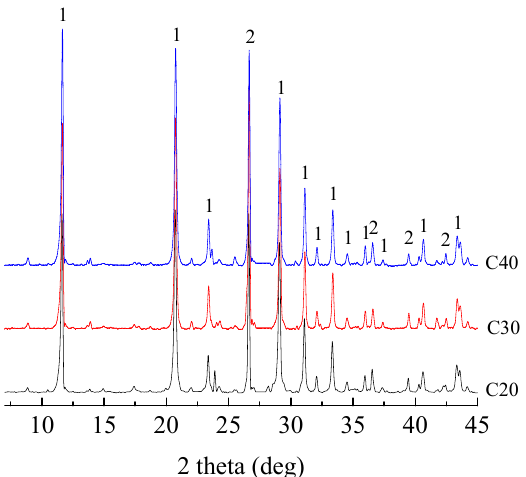
Figure 7. XRD patterns of the powdery precipitated substances at different water–cement ratios: 1, gypsum (CaSO 4 2H 2 O); and 2, quartz (SiO 2 ).